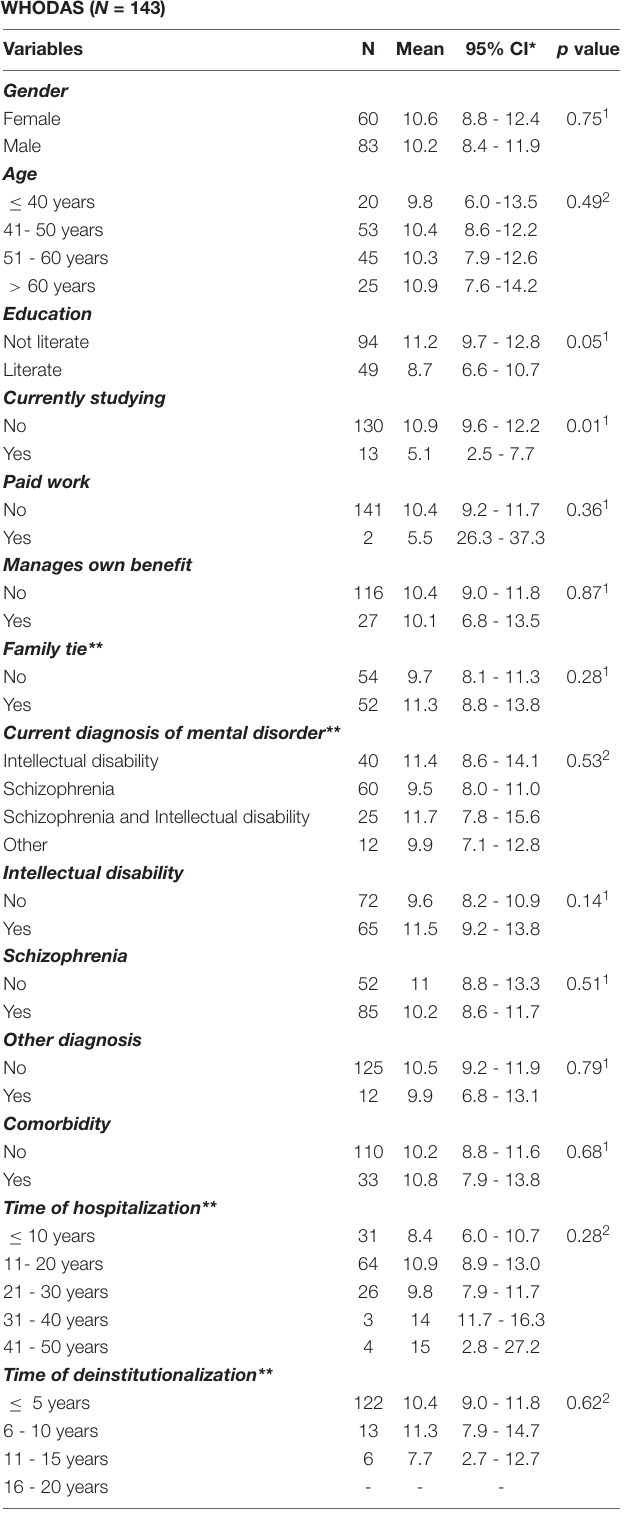
TABLE 5 | Distribution of people with mental disorders who underwent deinstitutionalization using assisted living facilities by sociodemographic and clinical characteristics according to WHODAS 2.0, 2019, n = 143.